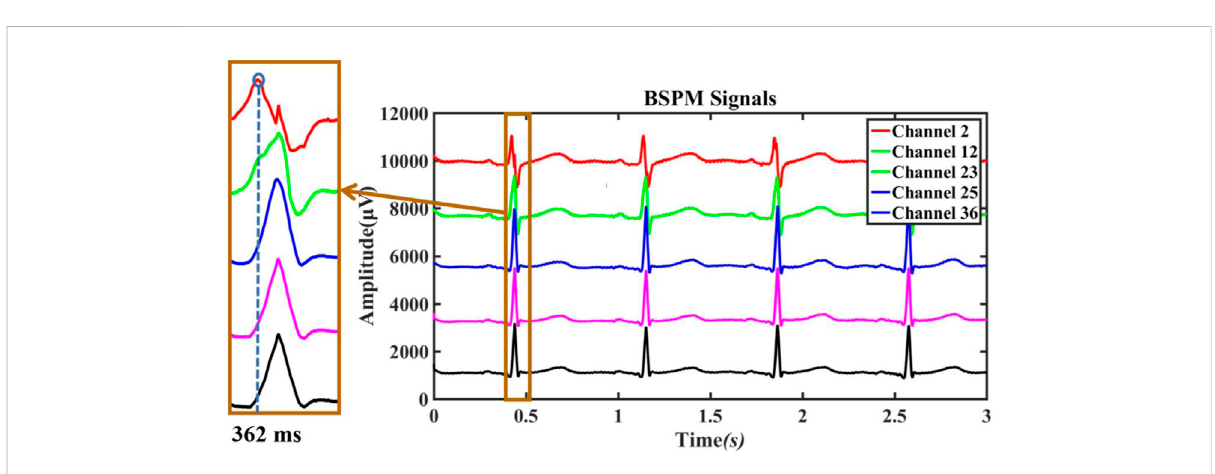
FIGURE 7 Original ECG data collected by channels 2, 12, 23, 25, and